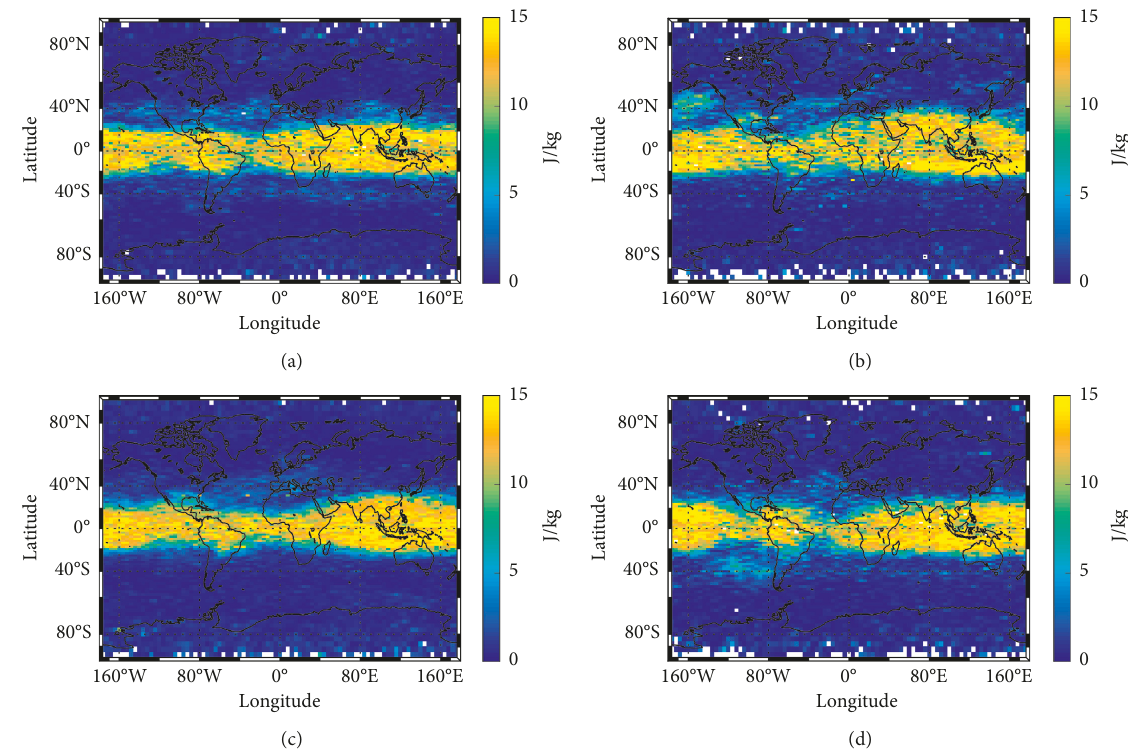
Figure 13: Global distributions of gravity wave potential energy at the height of 15–20 km in northern hemisphere. Spring (a), summer (b), autumn (c), and winter (d).